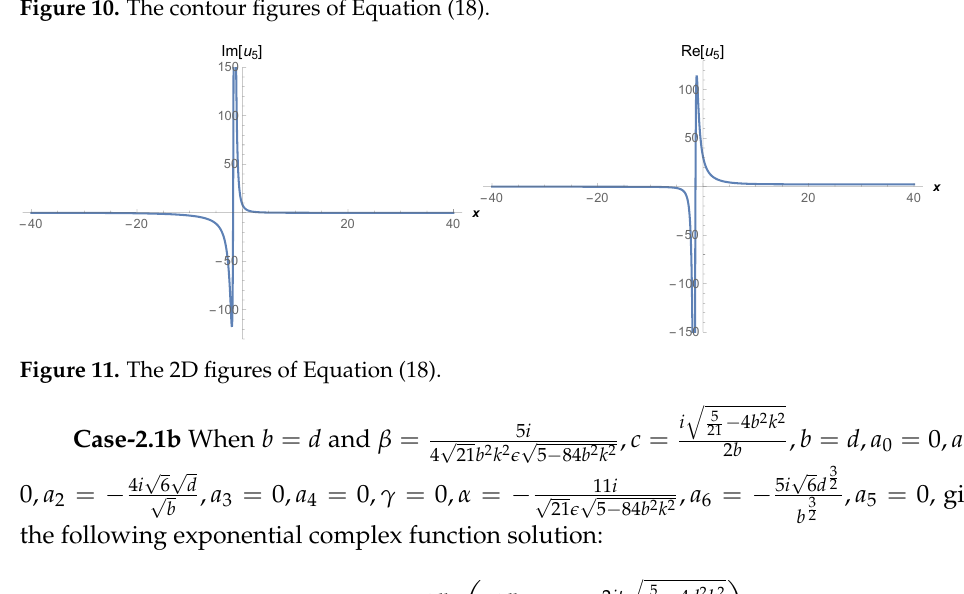
Figure 10. The contour figures of Equation (18).